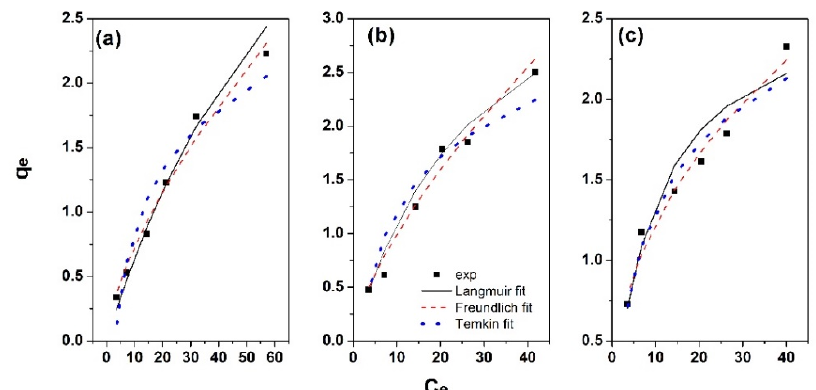
Figure 9. Non-linear regression models of Zn ions adsorption on magnetite modified adsorbents: laurel ( a ), canelo ( b ) and eucalyptus ( c ). Table 4. Non-linear adsorption isotherm fitting parameters on magnetic adsorbents. Isotherm Parameter Laurel Model/Adsorbent